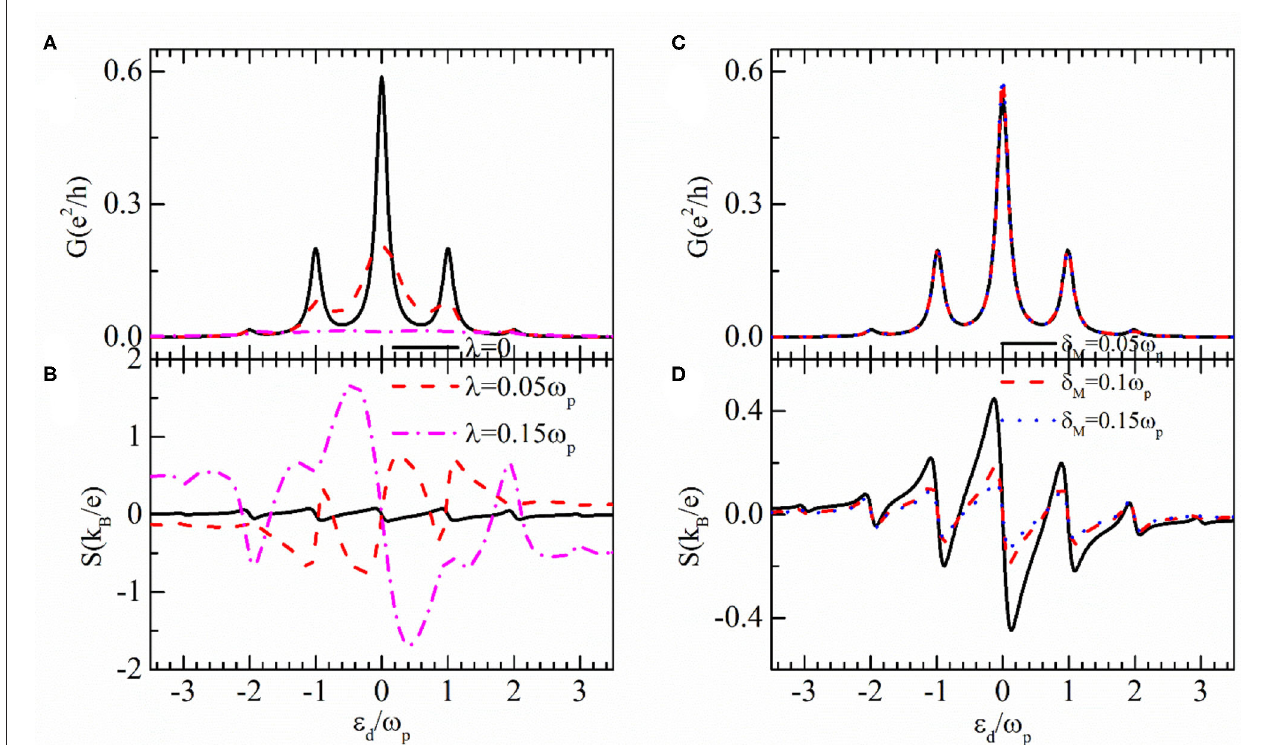
ω p as functions of the dot level for different values of dot-MZMs = 0.05 ω p . The equilibrium temperature is chosen as T e =